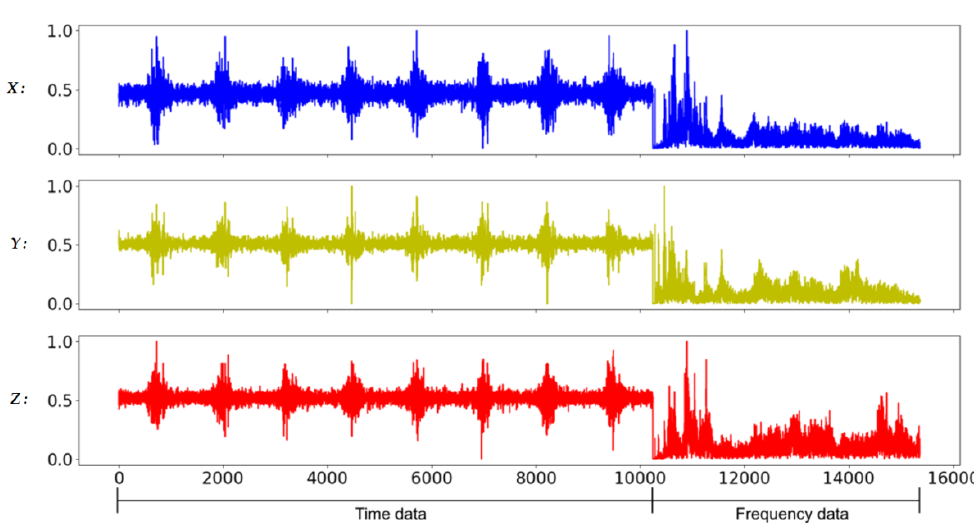
Figure 12. Full-time combining full-frequency (FTCFF) data with normalization.